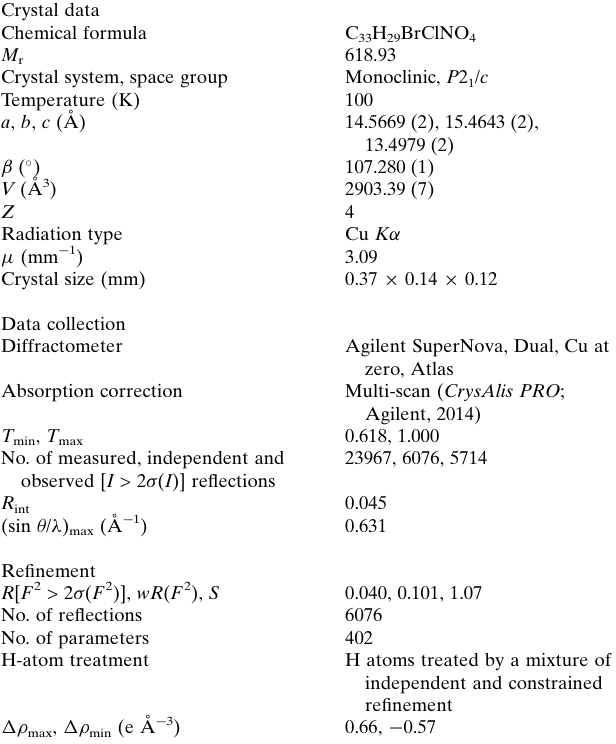
Table 2 Experimental details. Crystal data Chemical